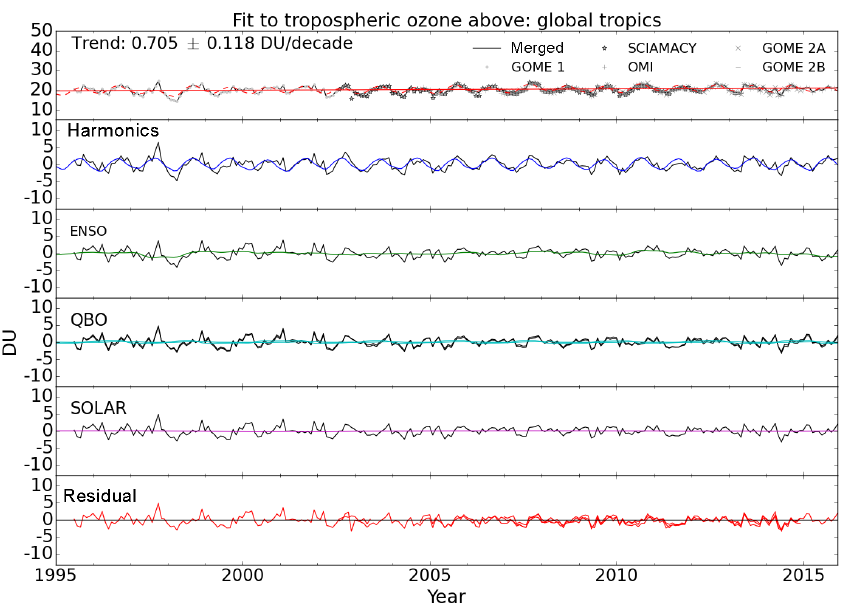
Figure 7. Fit of the tropically averaged tropospheric column ozone for the years 1995 to 2015. Top: the merged data product with the fitted linear trend is shown, the individual instruments are shown for comparison. In the next panels the harmonic functions, and the indexes for ENSO, QBO and solar activity are shown. To illustrate the instrumental variance, the bottom panel displays the residuals for the individual instruments.